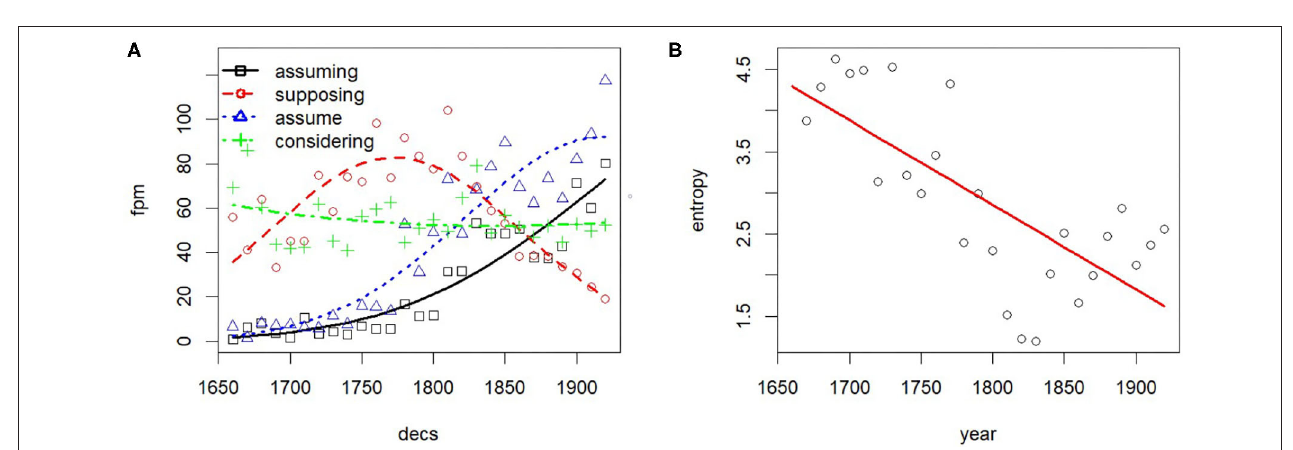
FIGURE 10 | Entropy decrease on specific WE clusters signals convergence in usage. (A) Relative frequency. (B)